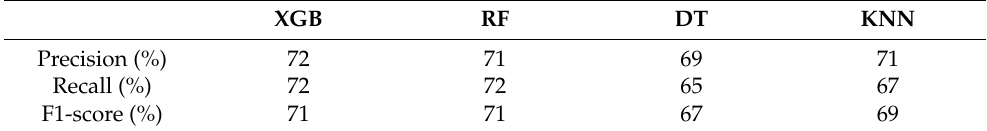
Table 4. Performance of classical ML models from Narmilan et al. [74] to detect WLD.